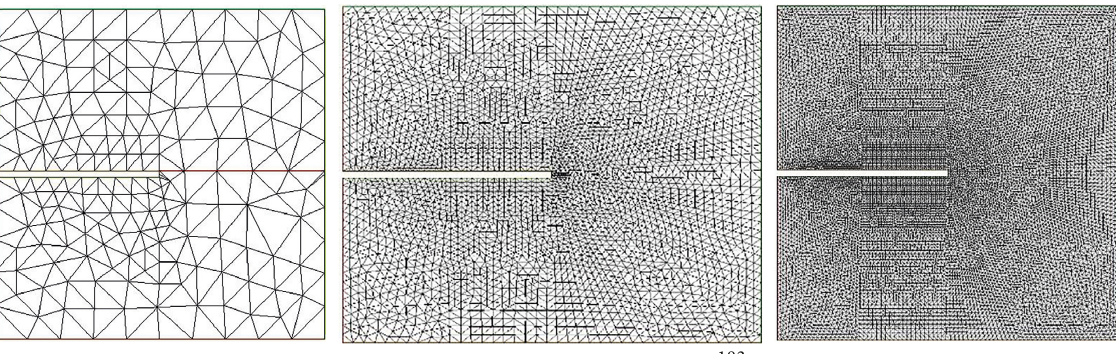
Figure 1: Computational meshes (from left to right): coarser, refined, and